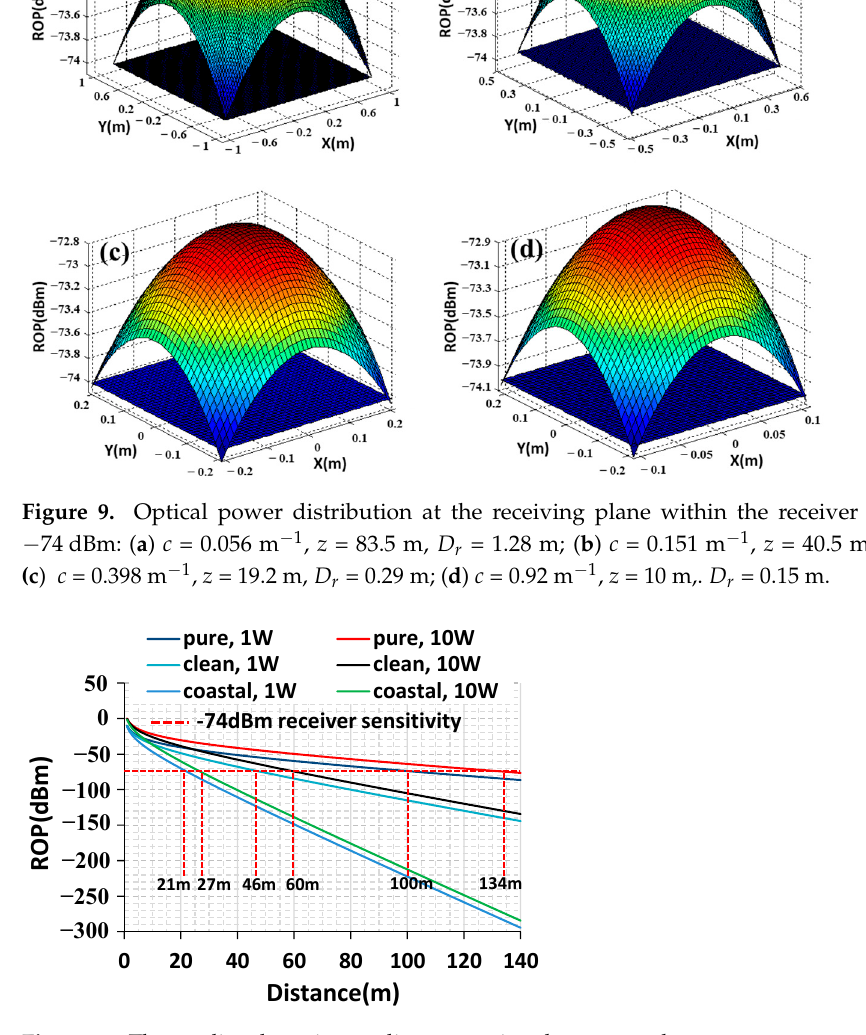
Figure 10. The predicted maximum distances using the proposed system.